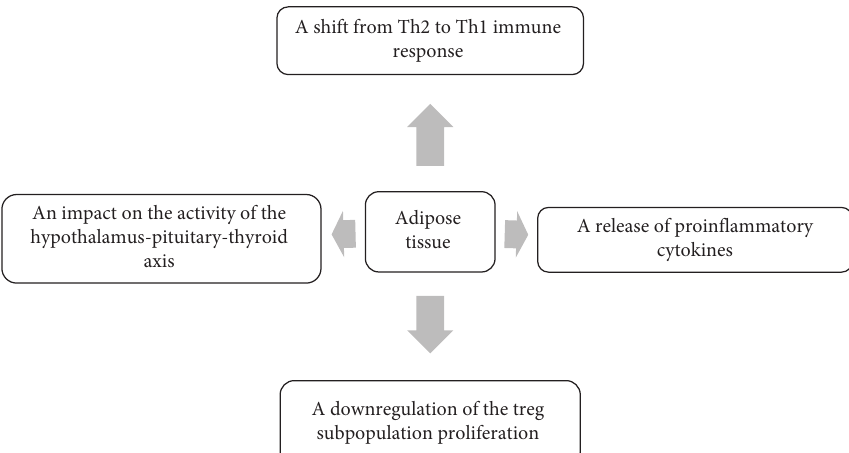
Figure 1: The potential impact of adipose tissue on the mechanism of thyroid autoimmunity and thyroid